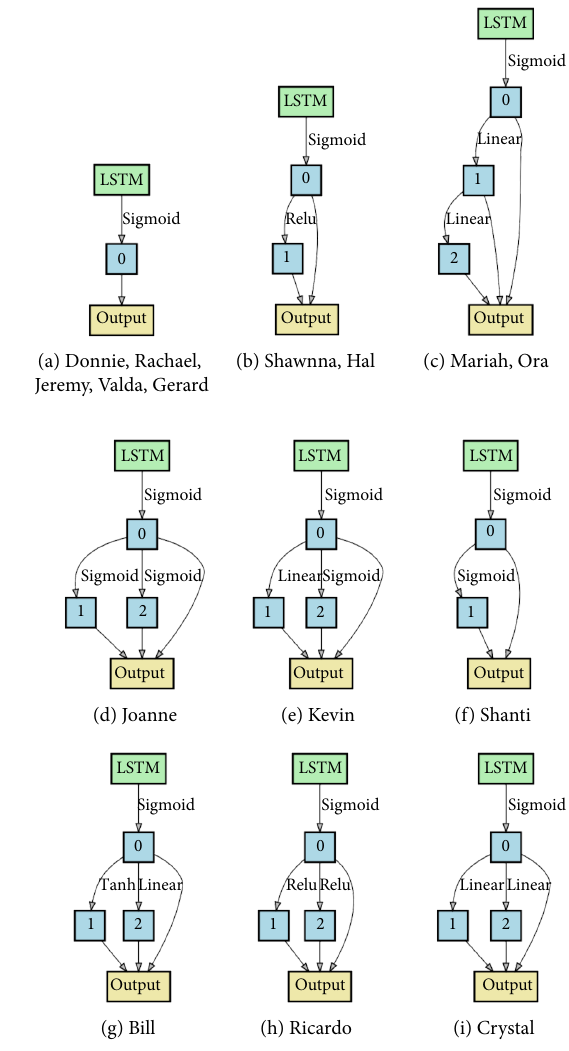
Fig. 10 DARTS cells generated for different